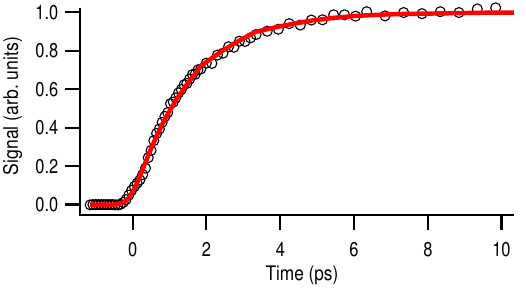
Figure 7. 1D transient for the amplitude of the main contribution as a function of time. ( ◦ ) experimental data and ( - ) fit. See text for more